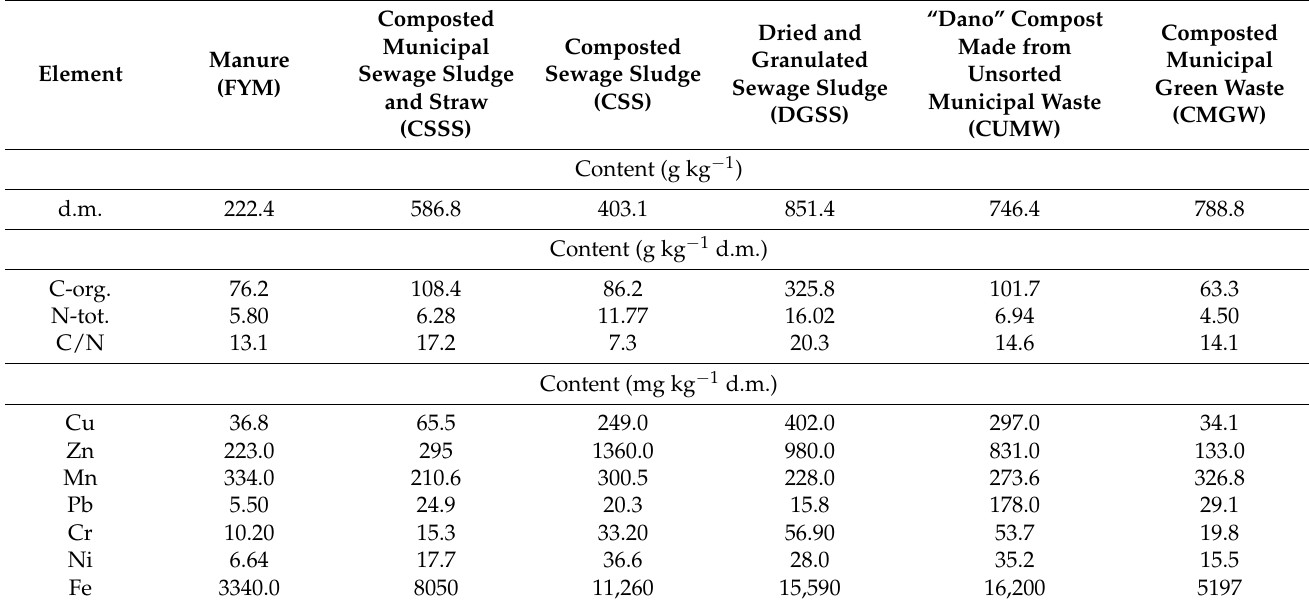
Table 1. Content and load of C-org., N-total and N introduced to soil with waste organic materials.